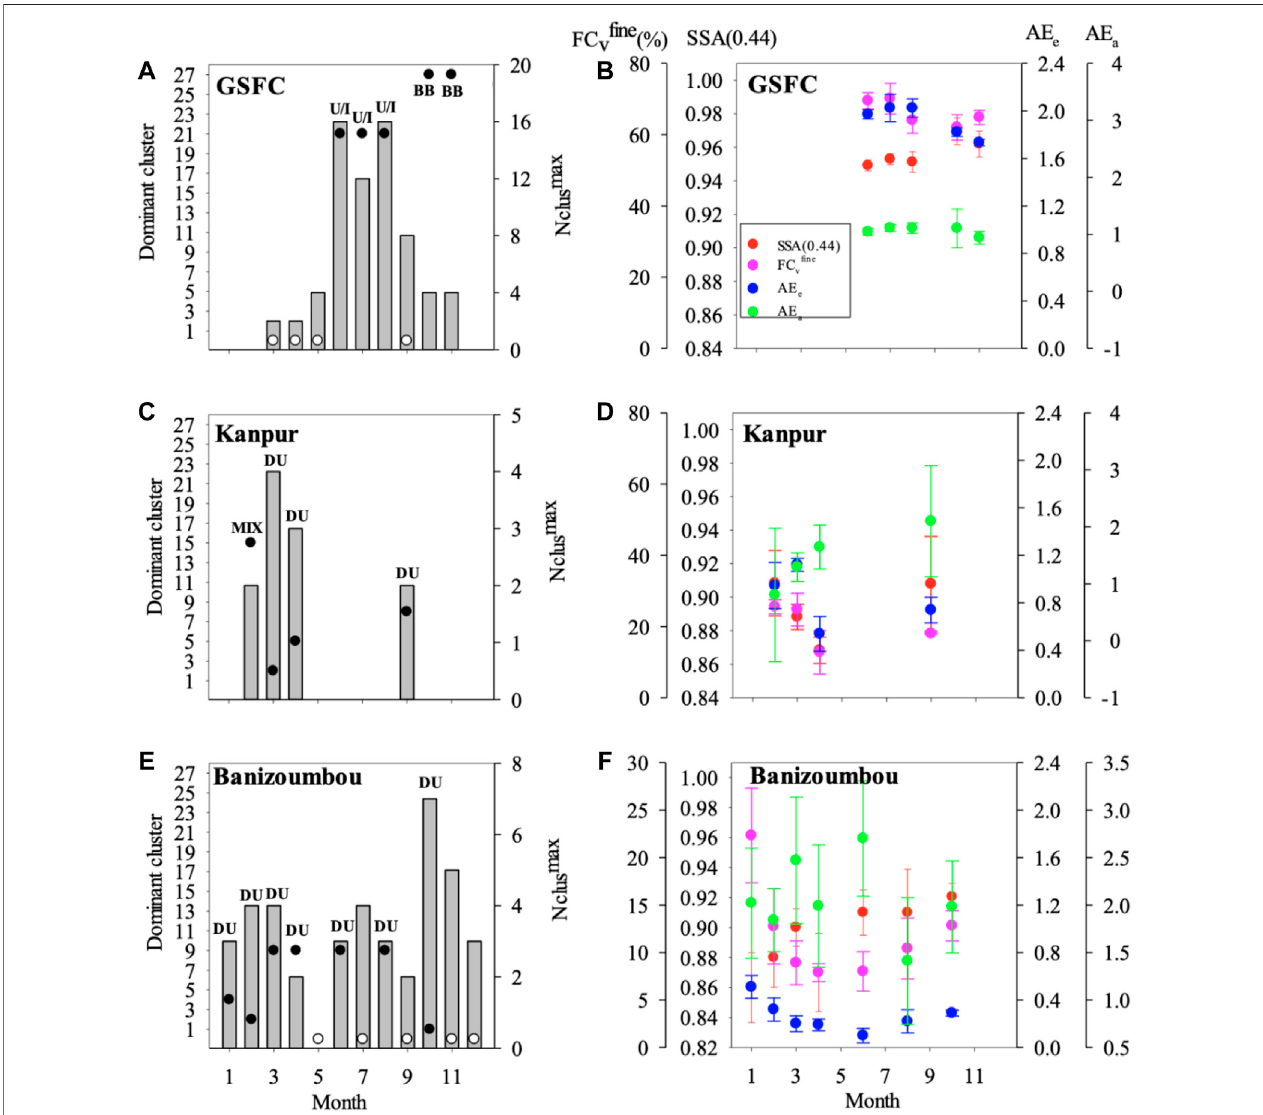
FIGURE7| Site-speci fi cmonthlyvariabilityofPAM-derivedaerosols.GSFC (A,B) ,Kanpur (C,D) ,Banizoumbou (E,F) ,dominantaerosolsub-typeids(leftpanels, solid circles), types (bold legend) and their mean properties (right panels), co-dominance of clusters (left panels, empty circles), N clusmax is the number of records for the dominant